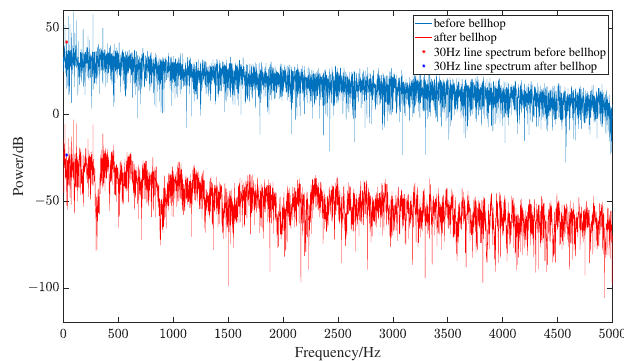
Figure 7. Spectrum of 1 s radiated noise before and after the Bellhop